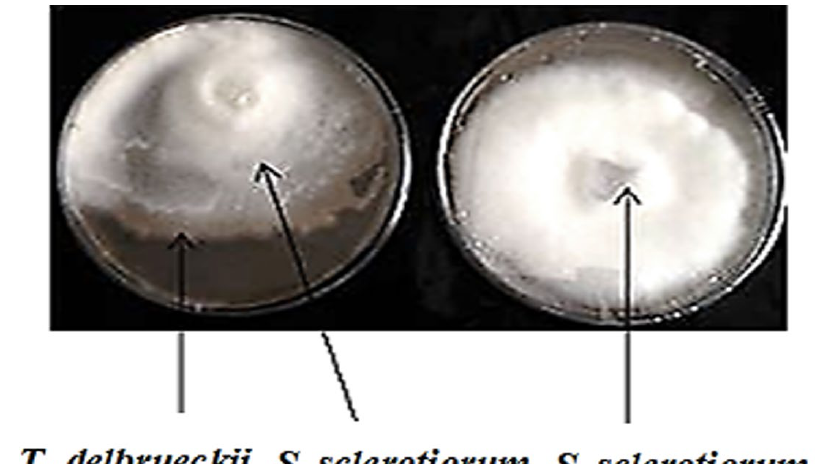
Fig. 4. A- Shows the diameter growth of S. sclerotiorum in the presence of T. delbrueckii yeast as a biocontrol control agent B- Shows the diameter growth of S. sclerotiorum without the presence of yeast (control treatment). The Petri dishes were grown and incubated at 25±2°C using the PDA culture medium for seven table 4. The diameters of the pathogenic fungal colonies and control treatment, as well as the percentage of inhibition (%) of using T. delbrueckii yeast as a biological control agent pathological The diameter of the The diameter of a pathogenic The percentage fungi pathogenic fungi colony in fungi colony in the presence